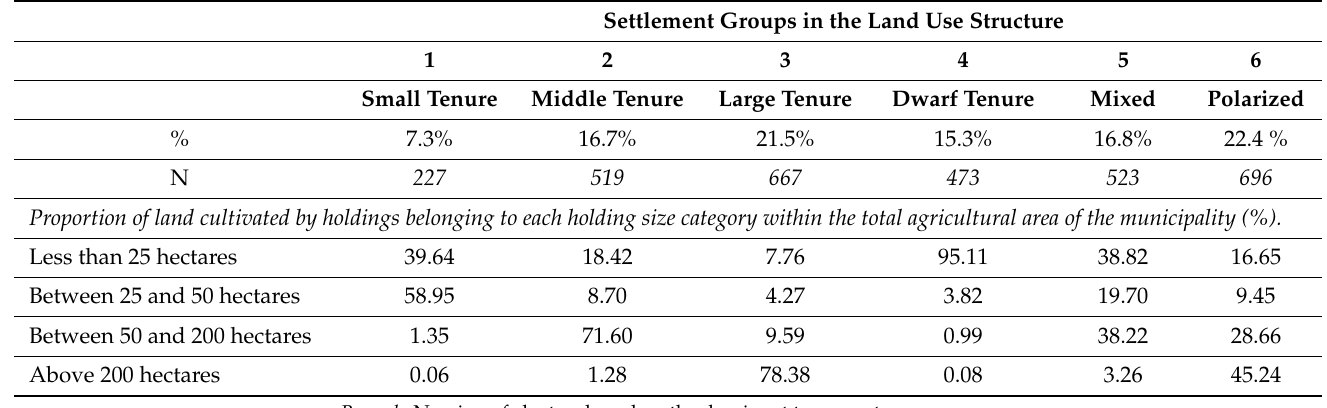
Table 2. Distribution of settlement groups of land use structure and averages of clustering